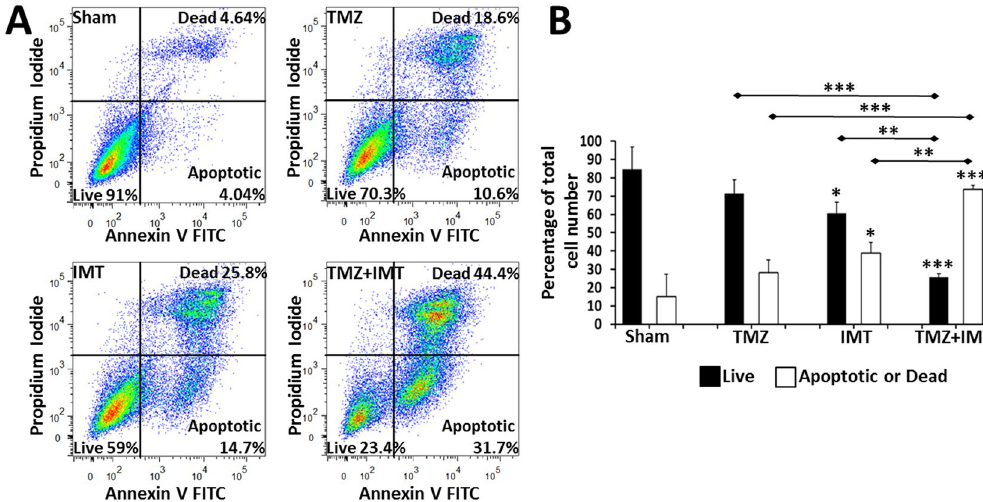
Figure 2. Flow cytometry measures of IMT response in patient GBM cells. ( A ) Representative scatterplots of annexin and propidium iodide (PI) labeling of apoptotic and dead patient GBM cells, respectively, after a 3-day exposure to the indicated treatment. IMT produced a greater cytotoxic effect than TMZ but the number of apoptotic and dead GBM cells rose dramatically with combined therapy. ( B ) Quantitative flow cytometry revealed a significant difference (P < 0.001) between live and apoptotic/dead fractions within each of the sham, TMZ and TMZ + IMT groups, but not in the IMT group (P = 0.053). This corresponded to a significant loss of GBM cell viability with IMT, but not TMZ, and a cumulative increase in cytotoxicity with the combination of the two treatments. These studies were performed in triplicate using primary GBM cells from 3 different patients. Asterisks directly above the data bars indicate a significant difference from the respective sham value (e.g., live compared to live). Significance between indicated data pairs is depicted by the asterisk(s) above the horizontal lines. Data are presented as mean ± standard deviation with significance indicated at P * < 0.05, ** < 0.01 and *** < 0.001.